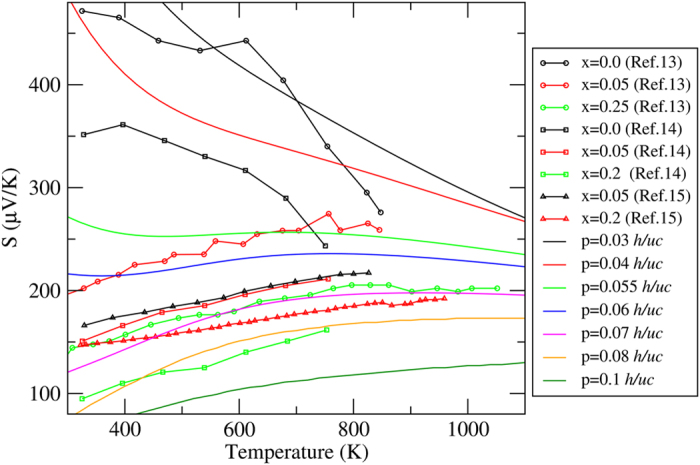
Calculated S versus temperature compared with experimental data for Ca5−xNaxAl2Sb6 [Tobereret al.13], Ca5Al2−xMnxSb6 [Zevalkink et al.14], and Ca5Al2−xZnxSb6 [Snyder et al.15], where p presents the theoretical hole carrier concentration.